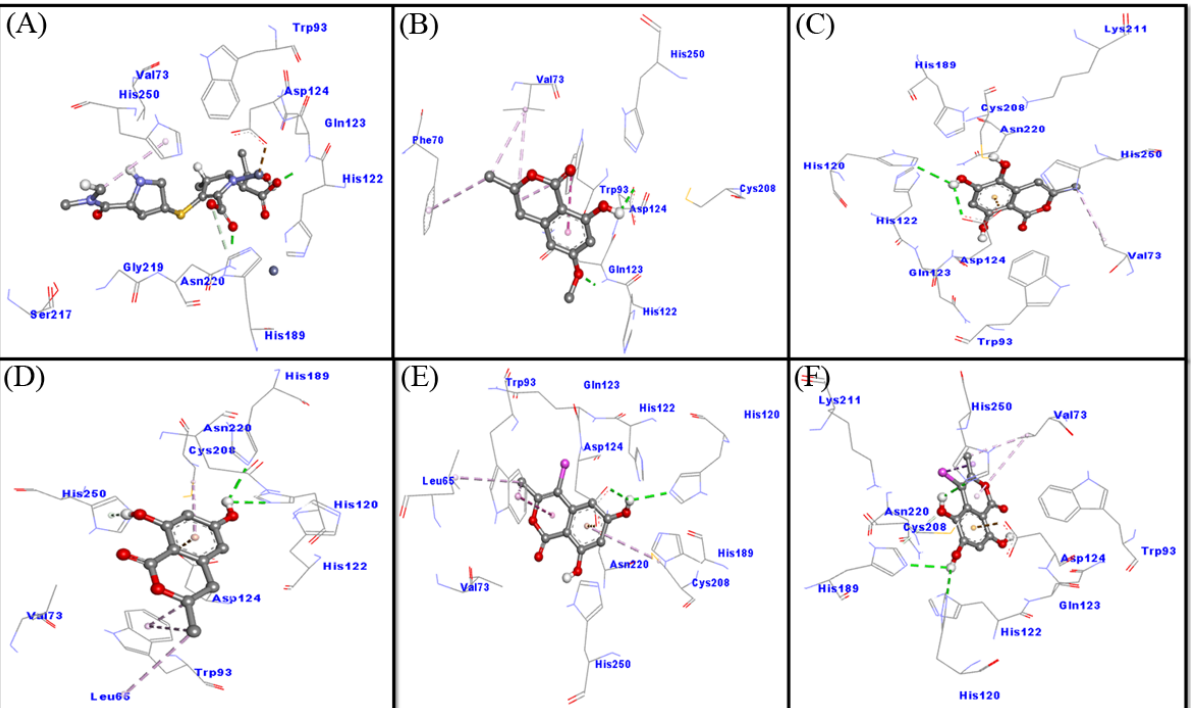
Figure 3. Binding mode of the ligands: meropenem ( A ); compound 1 ( B ); compound 2 ( C ); compound 3 ( D ); and compound 4 ( E ) and compound 5 ( F ) inside the active site of NDM-1.